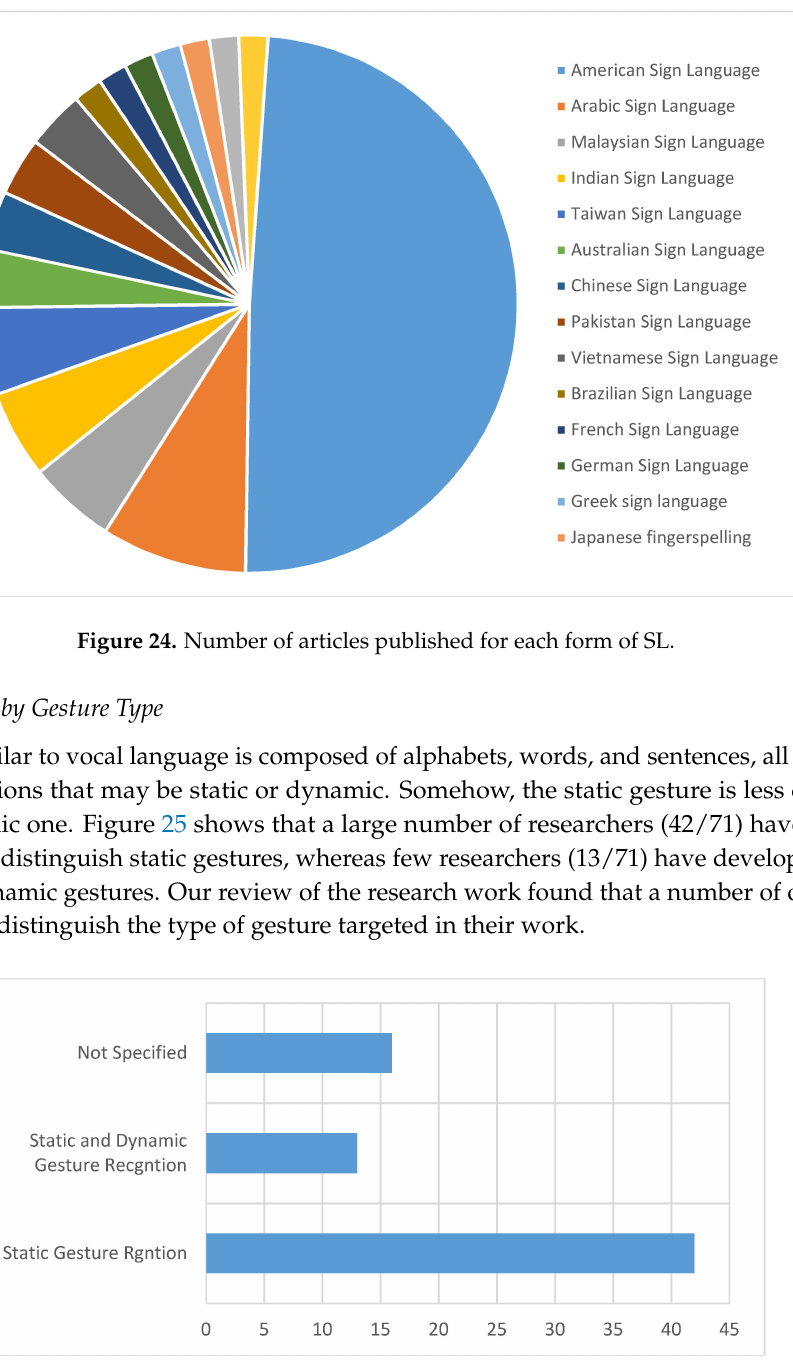
Figure 25. Number of articles that recognize static and dynamic